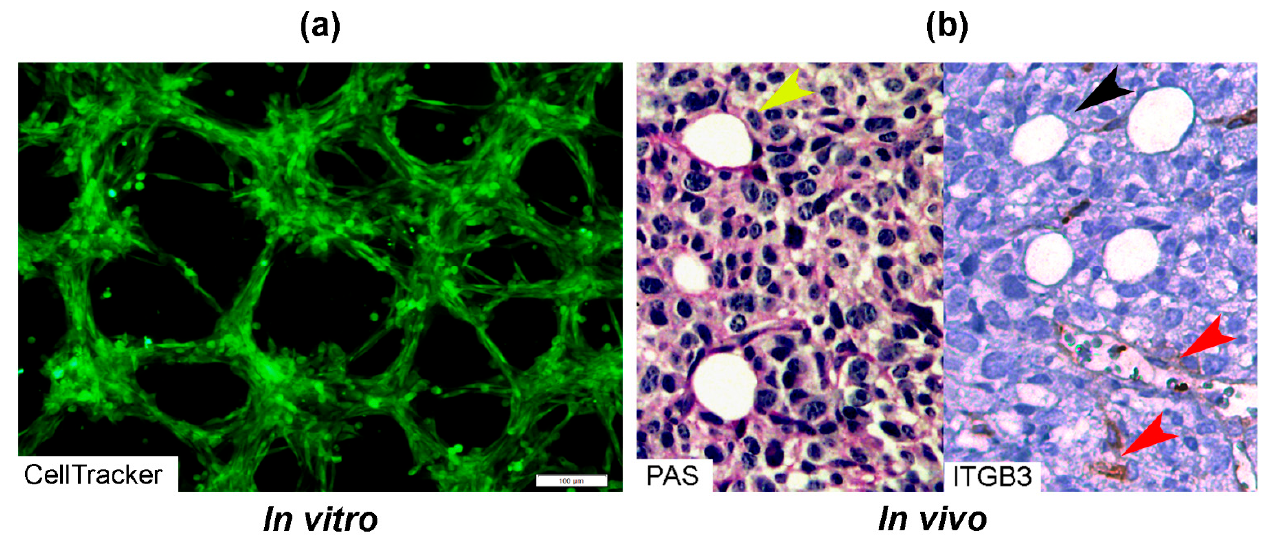
Figure 2. Photographs of vascular mimicry structures formed by the TNBC cell line MBCDF-Tum in vitro and in vivo. ( a ) MBCDF-Tum cells were labeled using Cell tracker-green (Abcam) and photographed by epifluorescence microscopy at 24 h of seeding (10 magnification, Olympus BX51). ( b ) MBCDF-Tum cells xenografted in nude mice generated VM-forming tumors. VM structures (yellow arrow heads) were identified by PAS-staining (magenta color, left side of the picture) in a tumor section. In the right part of the picture, a similar section of the same tumor was stained for Integrin- β 3 (ITGB3) as an endothelial marker, identifying tumor endothelial-vasculature (brown staining, red arrow heads) in a hot spot of ITGB3-negative VM channels (black arrow heads) (40 magnification).